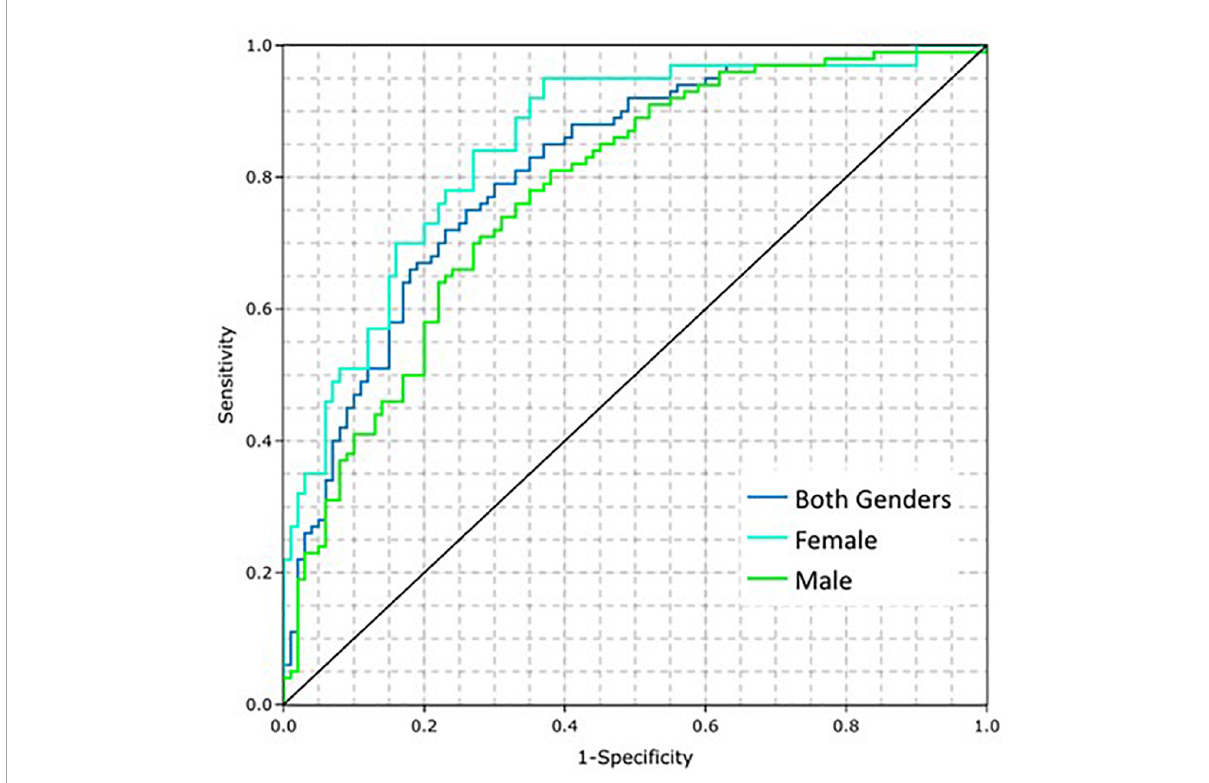
FIGURE4 Coronary artery disease (CAD) model performance on the training dataset by gender when adding the influence of